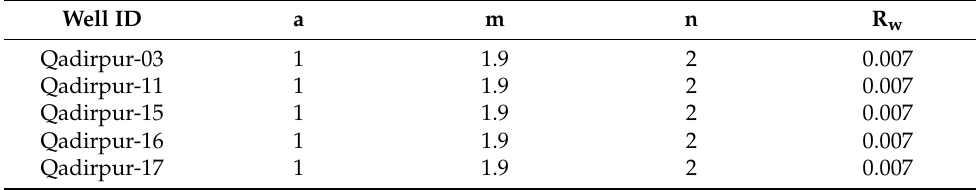
Table 2. Archie parameters for the QGF.